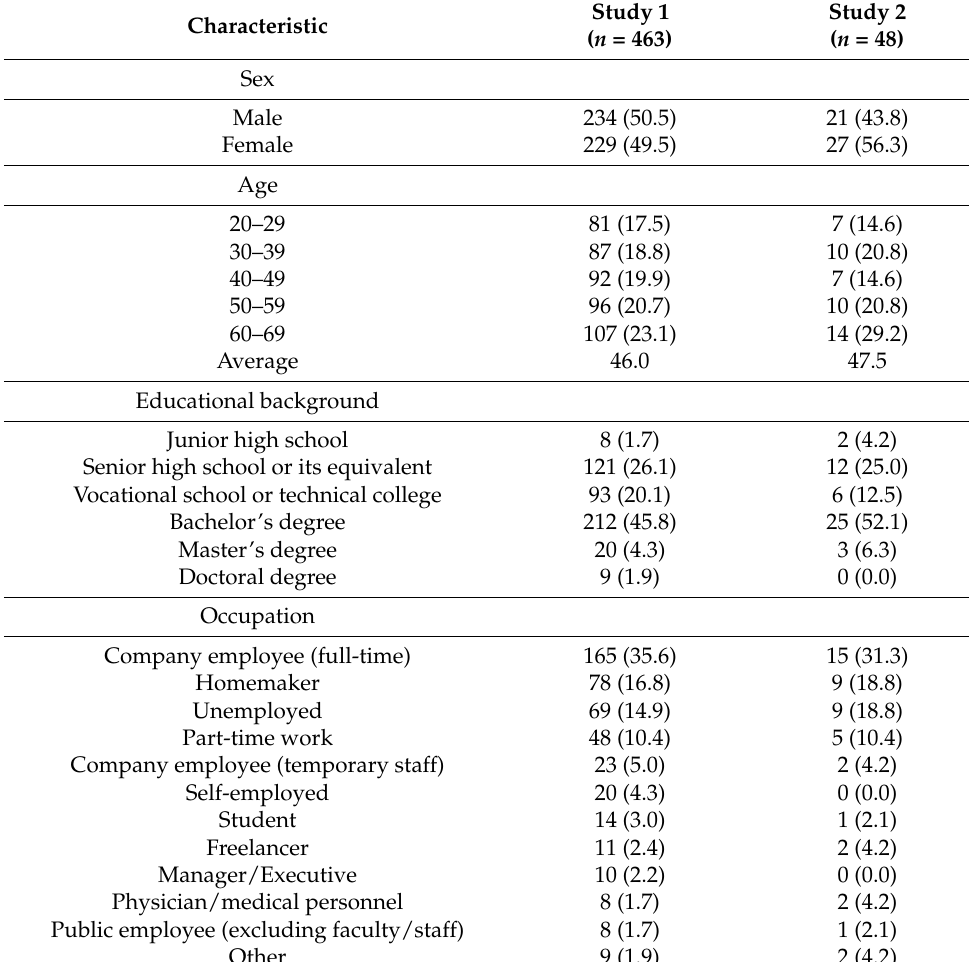
Table 2. Demographic features of respondents, n